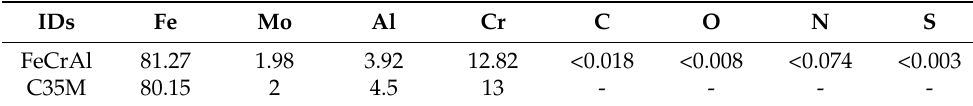
Figure 1. LPBF process. Table 1. Chemical composition of FeCrAl alloy and C35M (in wt.%).